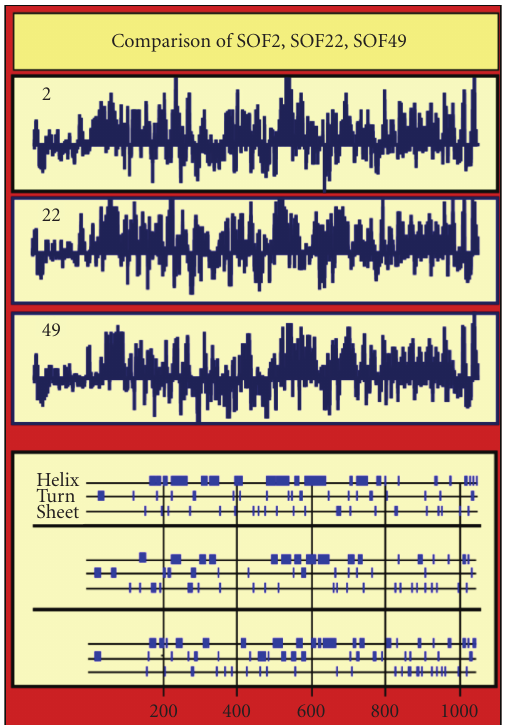
Figure 4: The predicted secondary structure of SOF is highly con- served among SOF from di ff erent serotypes. Only three serotypes were selected for comparison in order to have a manageable figure. The top figure indicates the degree of hydrophobicity/hydrophilicity and the bottom figure indicates location of helixes, turns, and B- sheets. The numbering of the amino acids is indicated.